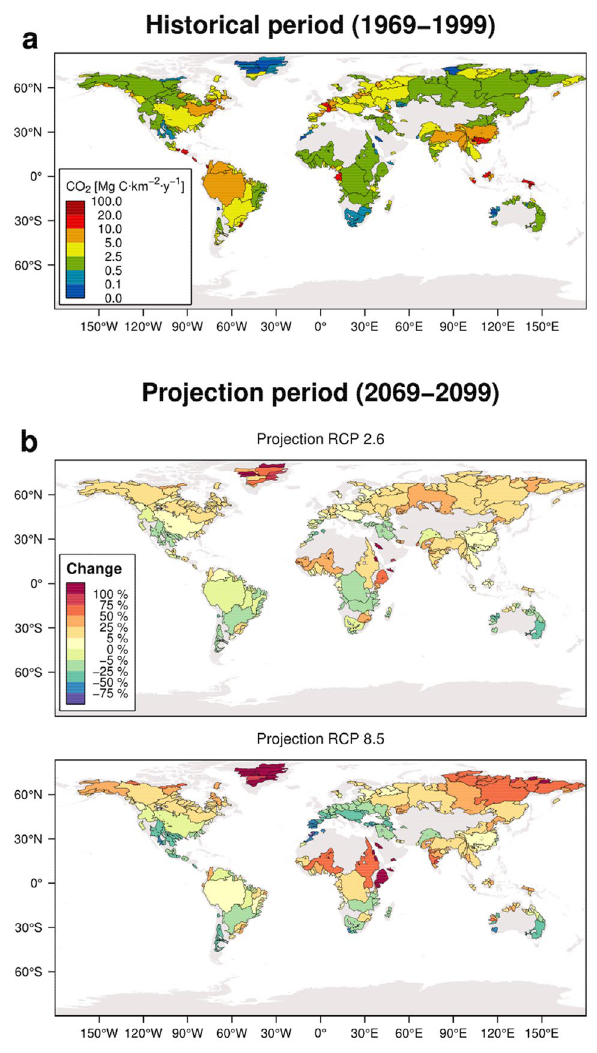
Figure 2. (a) Interannual mean CO 2 consumption through chemical weathering during the Historical period, expressed as Mg C year −1 km −2 ; and (b) relative change for the Projection (ECP) period in the RCP 2.6 and RCP 8.5 climate scenarios, expressed as a percentage of change regarding the Historical period. The maps were created with the R software (version 4.0.3; https:// www.r- proje ct.